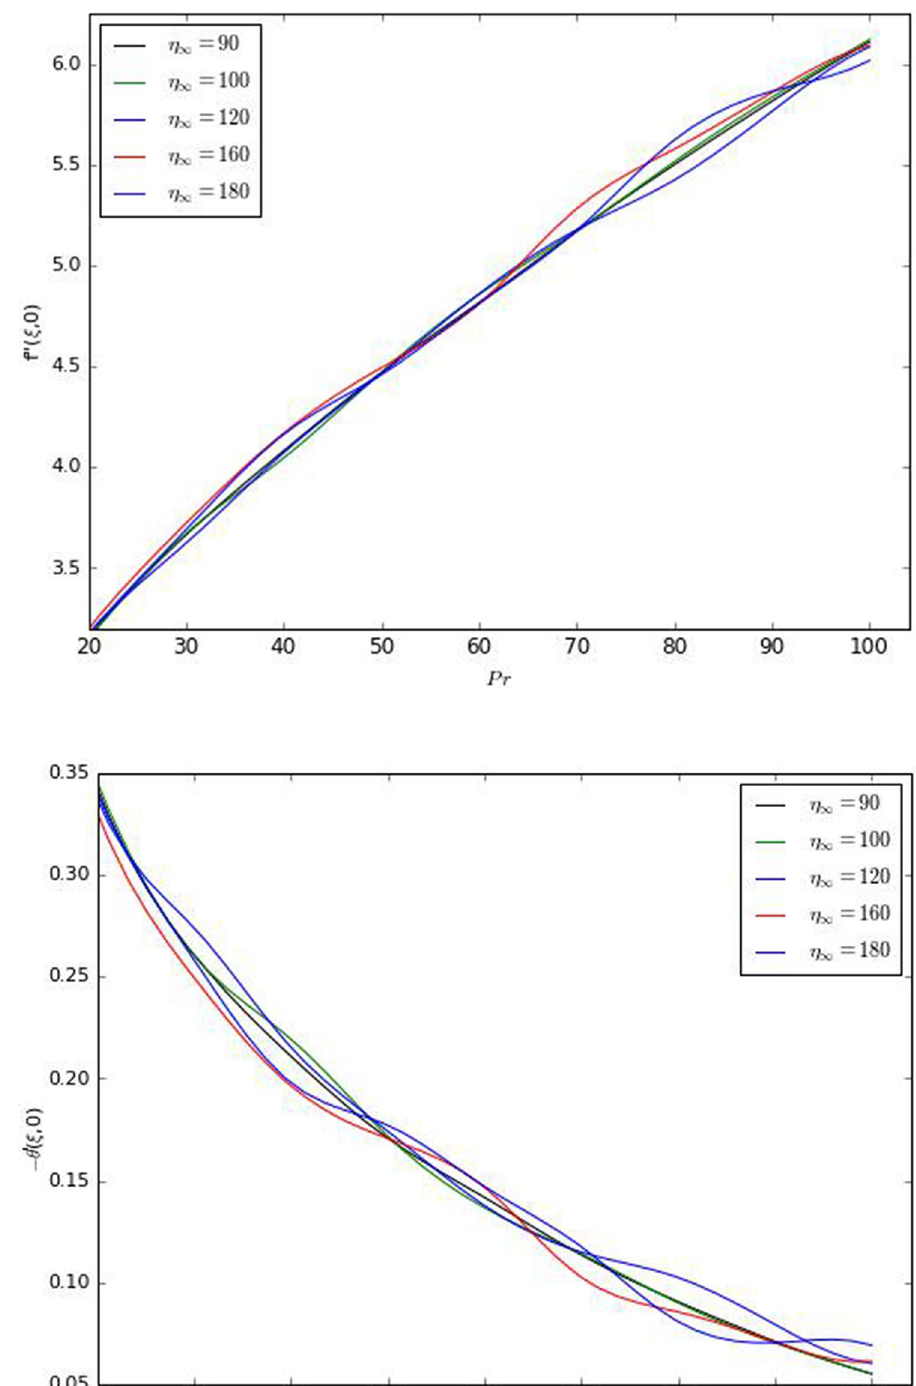
Fig. 2 Velocity profile for dif- ferent 𝜂 ∞